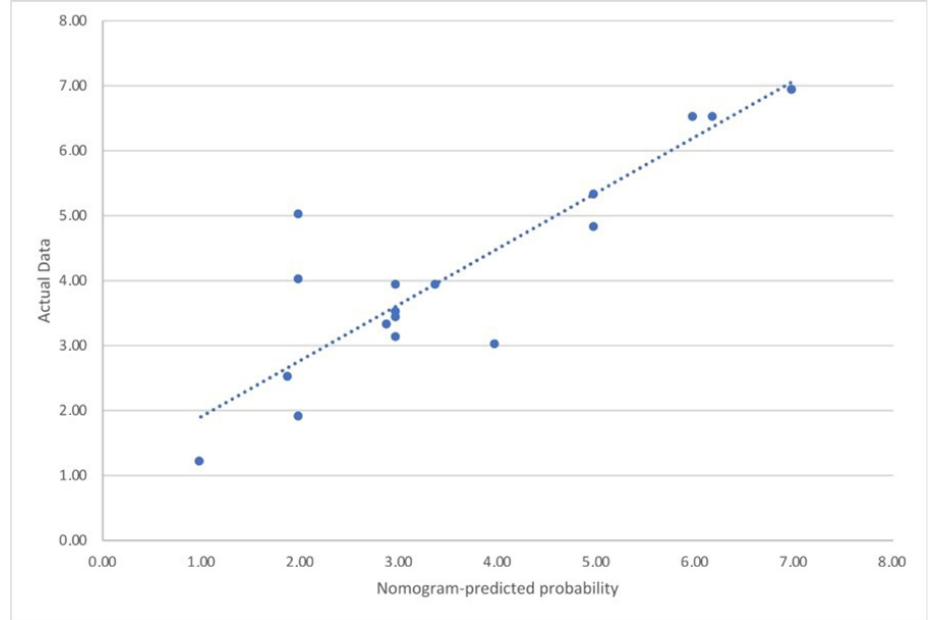
Figure 2. The figure shows the calibration curves for the nomogram-predicted probability of tes- tosterone deficiency and the need for testosterone therapy. In the validation data set, the area under the ROC curve was 0.85 (95% CI 0.71–0.93) (Figure